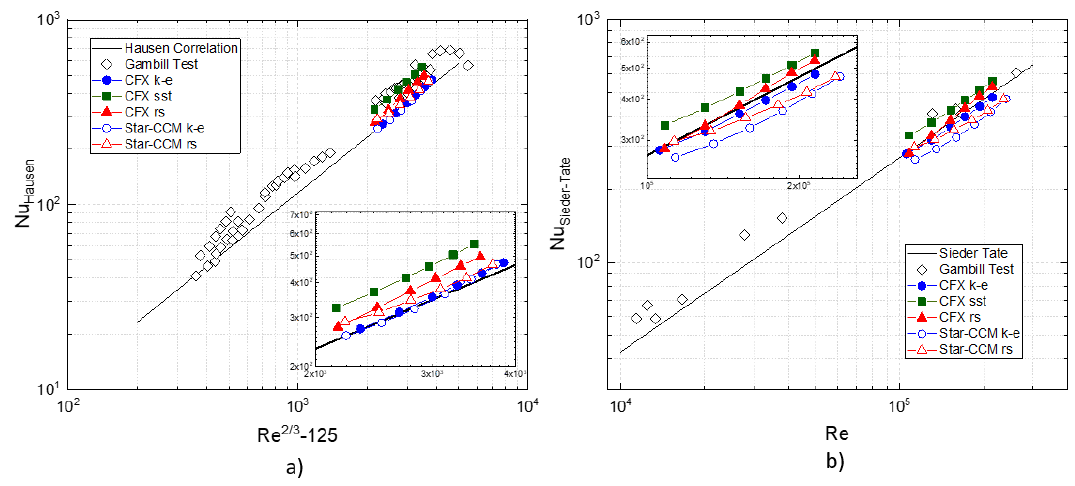
Figure 6: The results for the Hausen (a) and Sieder Tate (b) equations by using mesh 2a in Ansys CFX and mesh 2b in STAR-CCM+ are shown. Smooth walls were used.